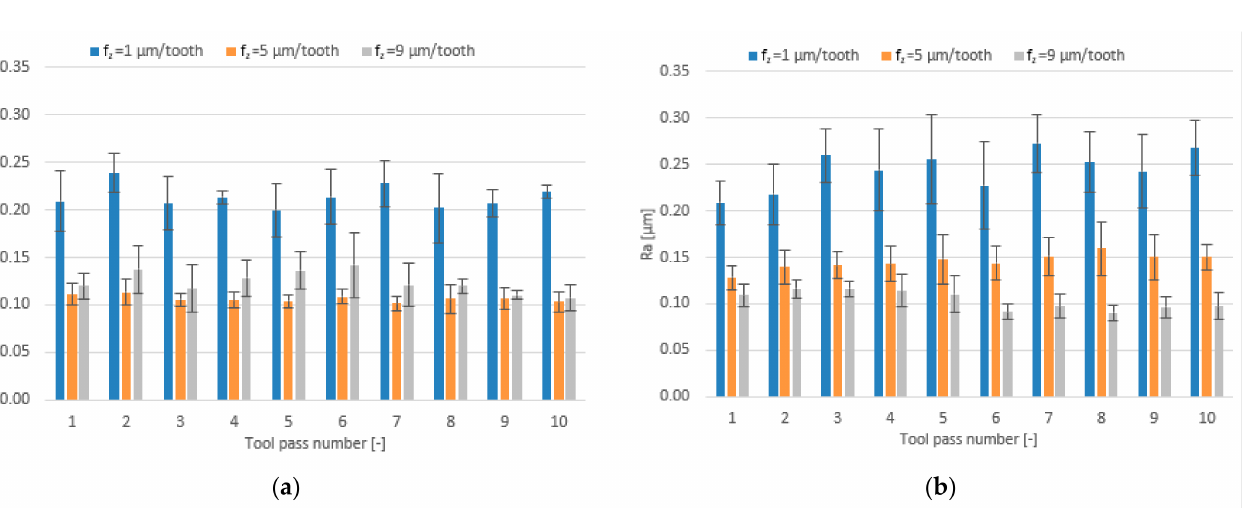
Figure 12. Feed per tooth f z versus surface roughness parameter Ra in the milling process performed using a tool coated with: ( a ) TiB 2 and ( b ) TiAlN; (v c = 800 m/min; a p = 80 µ m).